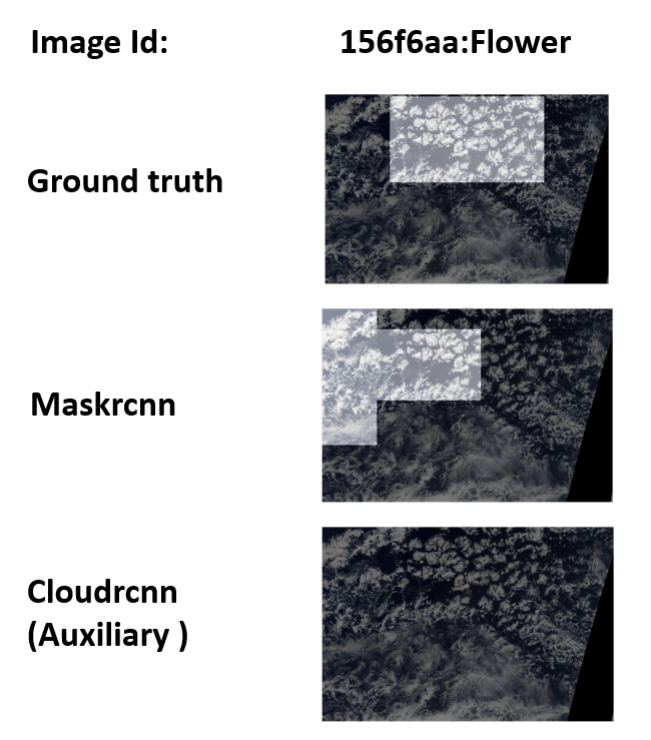
Figure 11. Misdetection example.